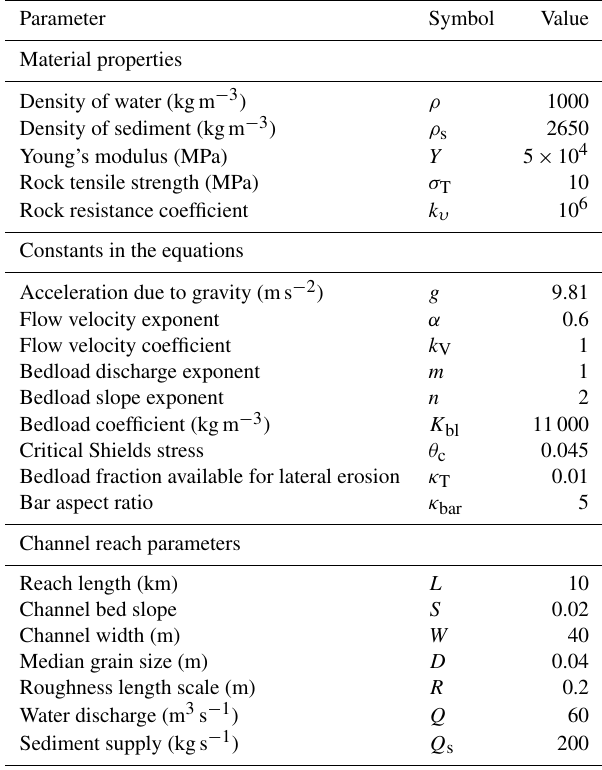
Table 1. Parameter values used for the example calculations, fol- lowing estimates by Turowski et al. (2007) for the Liwu River, at Lushui, Taiwan.